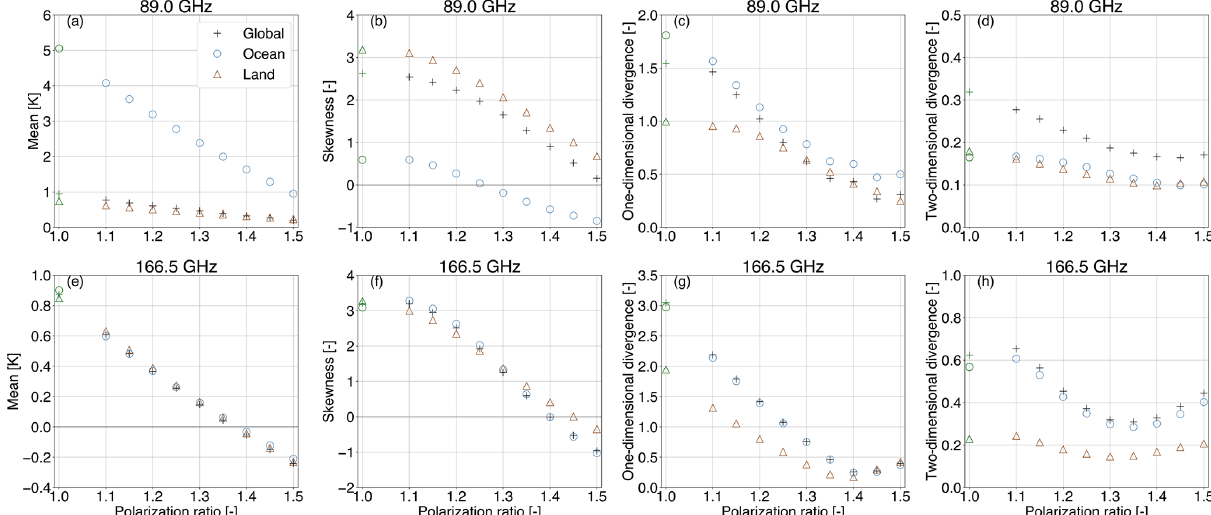
Figure 3. Statistical metrics, i.e., mean, skewness, and one-dimensional (1D) divergence, describing the differences in polarization differ- ences between observations and simulations, i.e., PD o − PD b , and the two-dimensional (2D) divergence between the observed (PD o – T o and simulated (PD b – T b ) 2D histograms of the arch-like relationship. Results are presented for 89.0 (a–d) and 166.5GHz (e–h) over land BV (brown triangles), ocean (blue circles), and globally (black crosses) for a period of 1 month (13 June to 13 July 2019) as a function of the polarization ratio ( ρ ). In terms of the control run ( ρ = 1), the corresponding differences are highlighted in green.